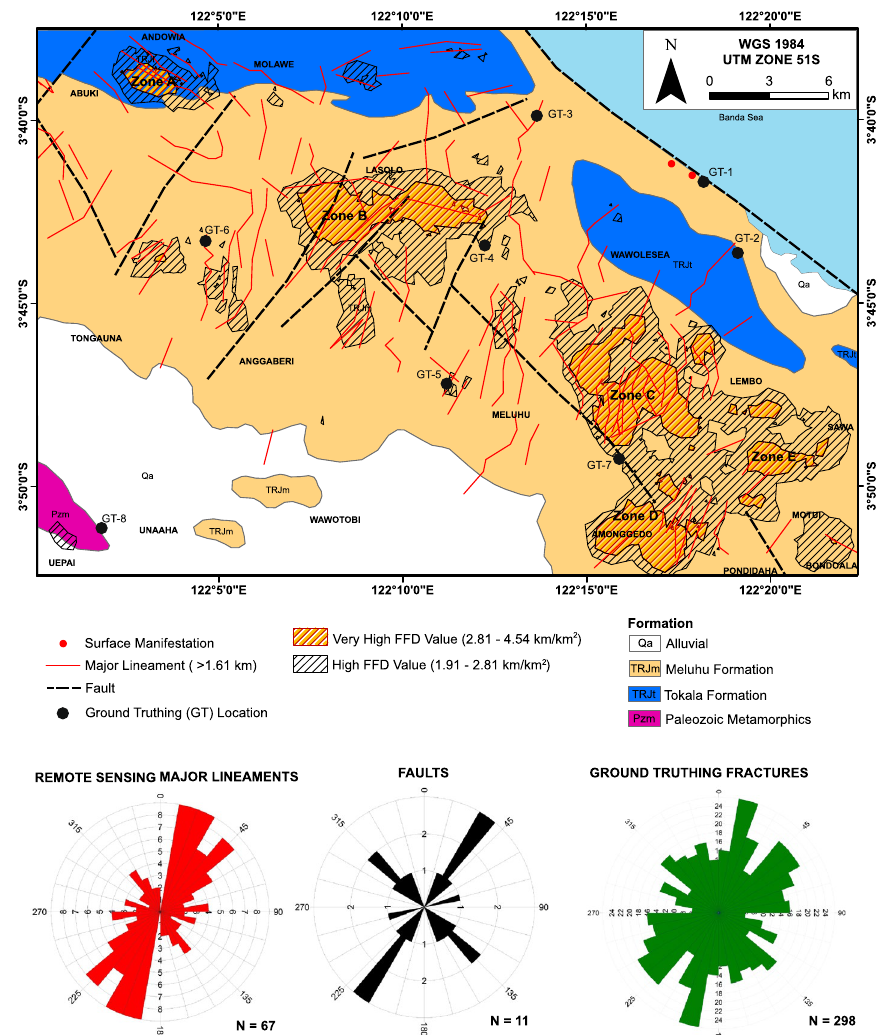
Fig. 13 Geological map of the study area with major lineaments and high–very high FFD values derived from lineament